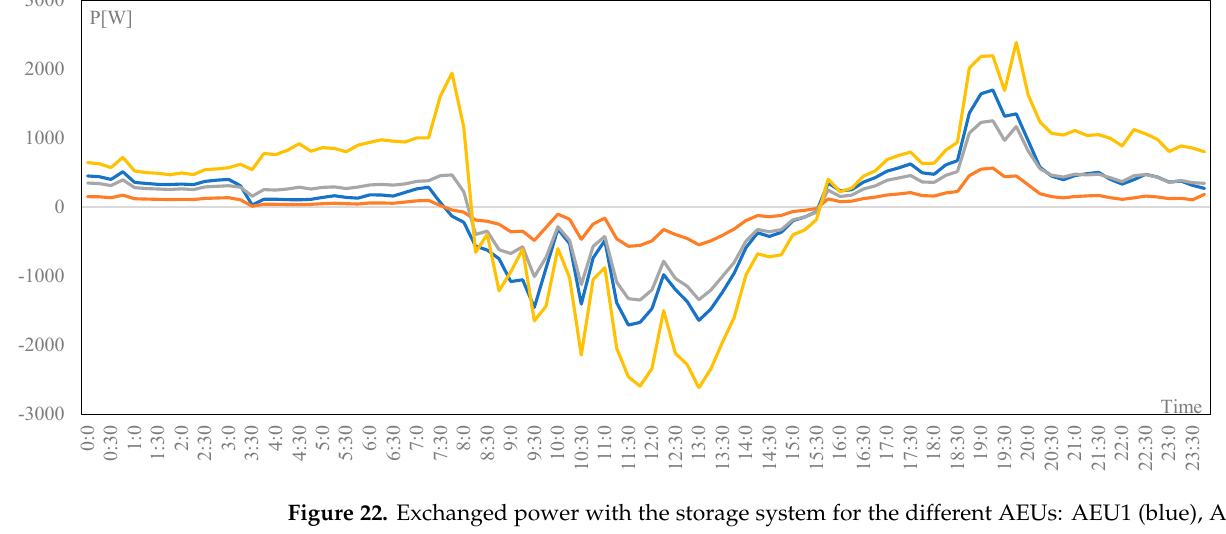
Figure 21. PV power production profiles for the different AEUs: AEU1 (blue), AEU2 (orange), AEU3